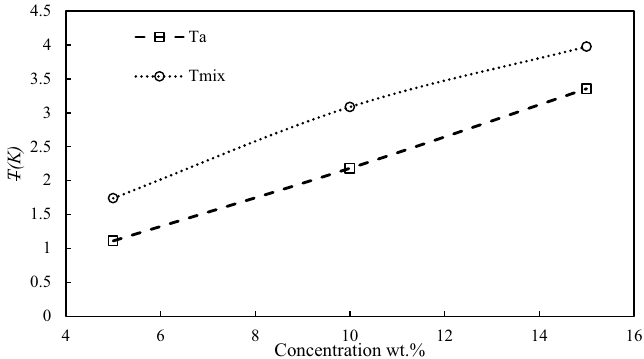
Figure 4. The effect of concentration on the average reduced temperature of 1:1 MEG + Gly mixture and the arithmetic mean of the reduced temperature of the individual components.